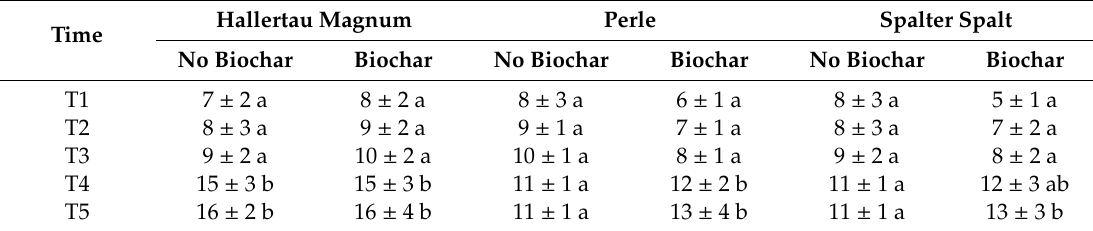
Table 1. Measurements of diameter of shoots (mean ± standard deviation) at five di ff erent times (T1: 30 June, T2: 18 July, T3: 27 July, T4: 3 November, T5: 21 November). Diameters within columns of each cultivar and treatment followed by di ff erent letters (a or b) are significantly di ff erent. Hallertau Magnum Perle Spalter Spalt Time No Biochar Biochar No Biochar